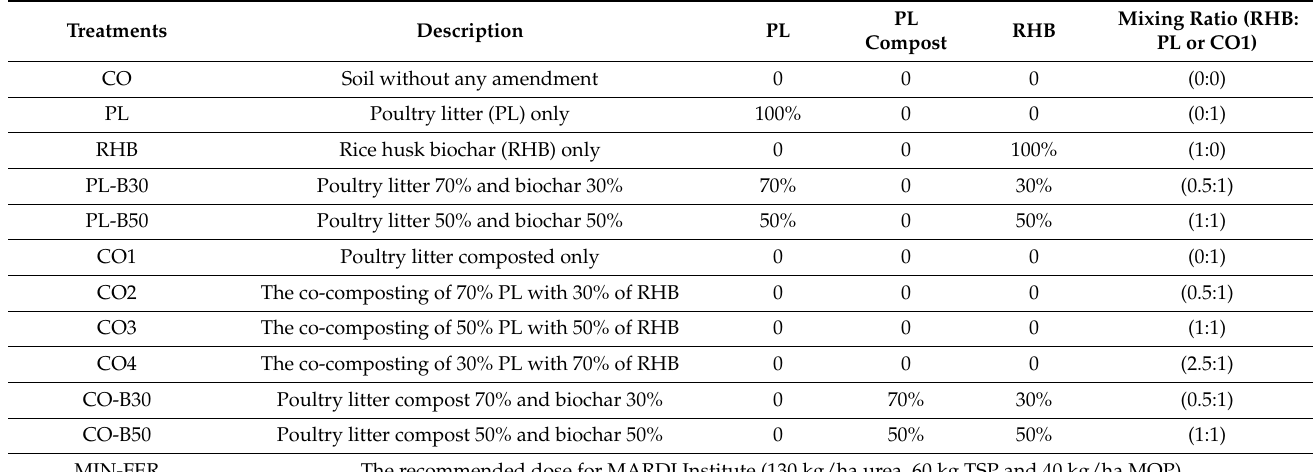
Table 1. List of treatments.